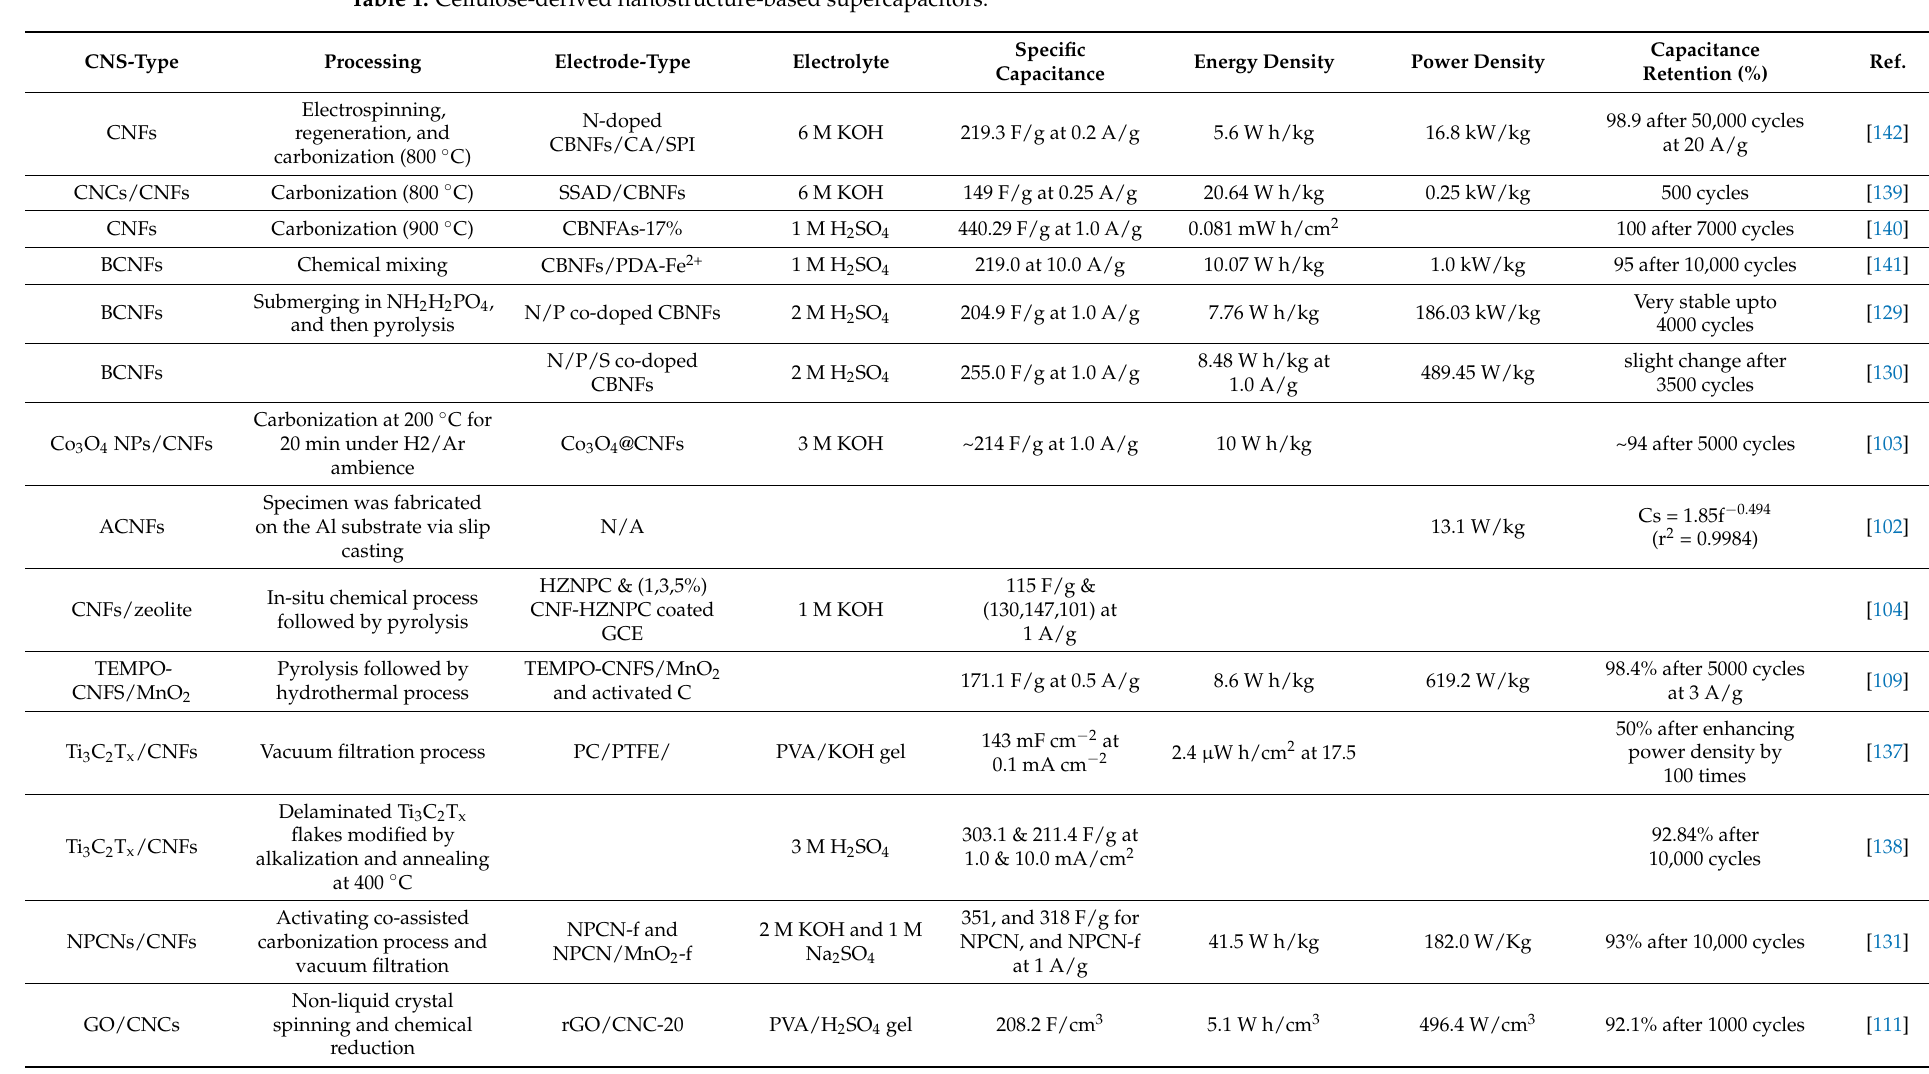
Table 1. Cellulose-derived nanostructure-based